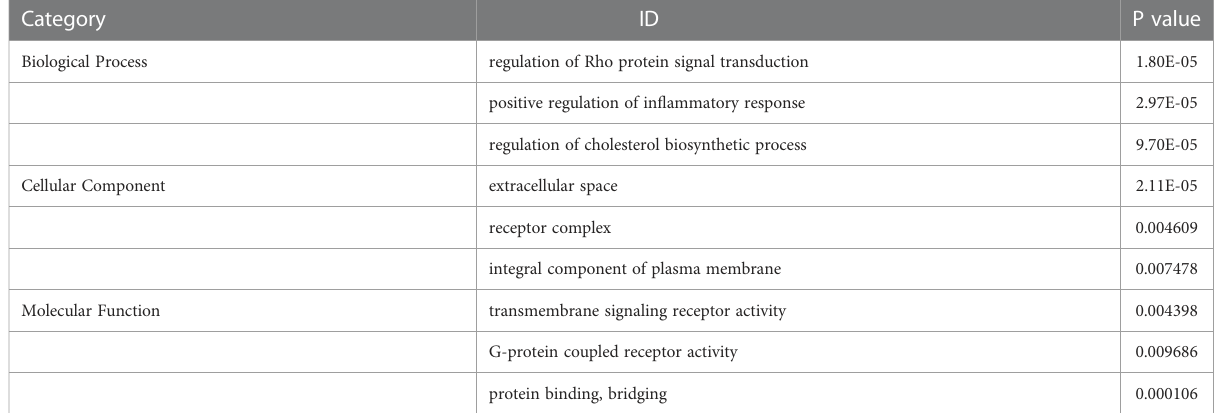
TABLE 5 GO term list of signi fi cantly differentially expressed genes between the experimental group at 48 h and 24 h.